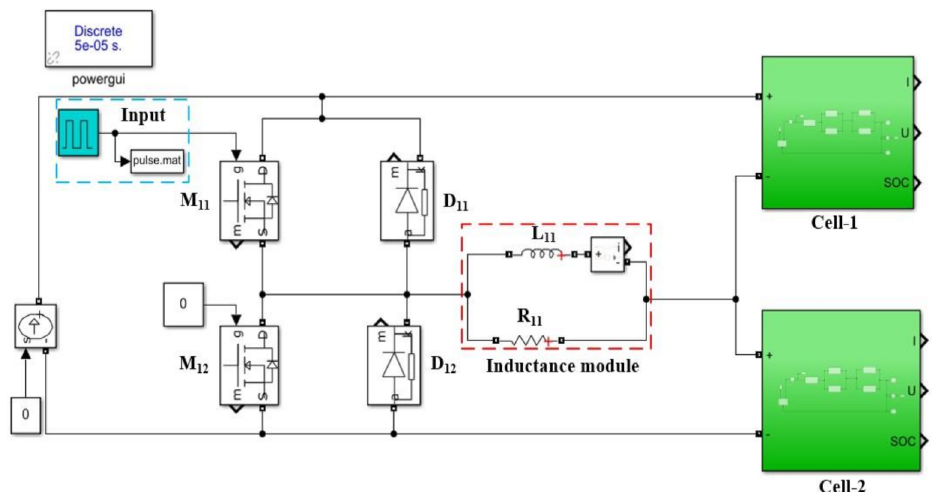
Figure 9. The simulation model of the intra-group equalization circuit.